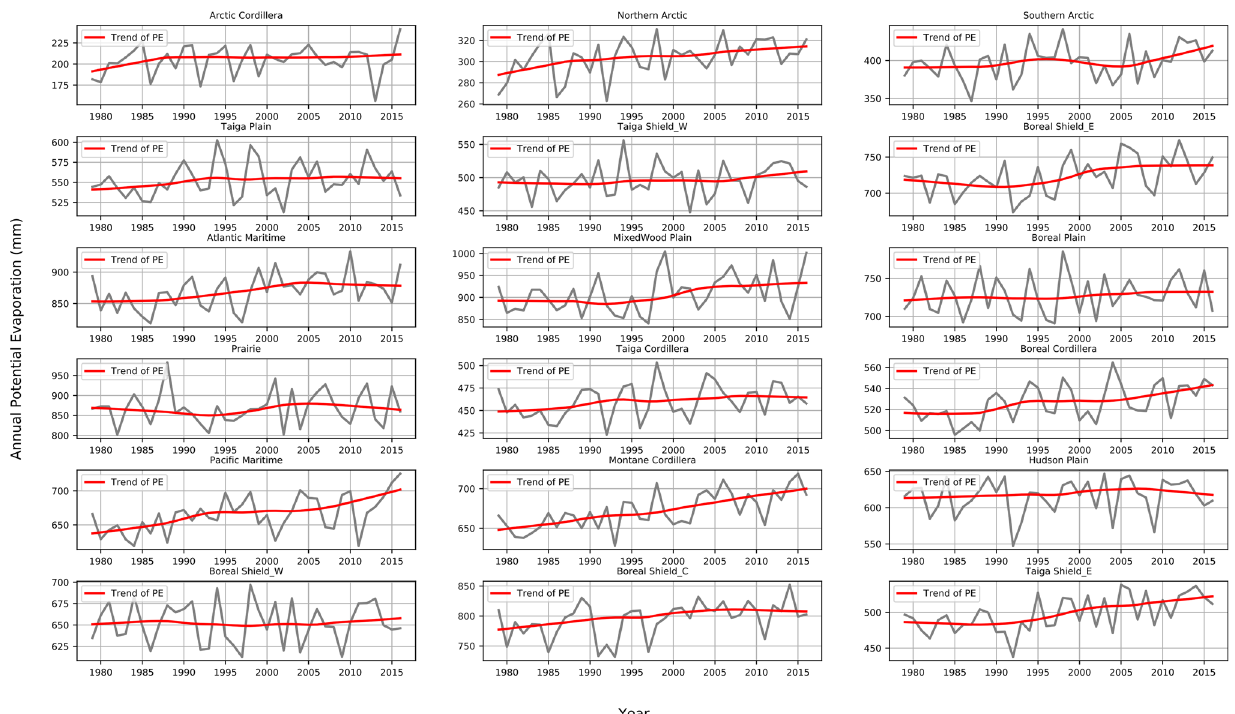
Figure 7. The temporal profile of annual potential evaporation (PE, mm) and the LOESS regression trends in 1979–2016 in the 18 ecozones in Canada.